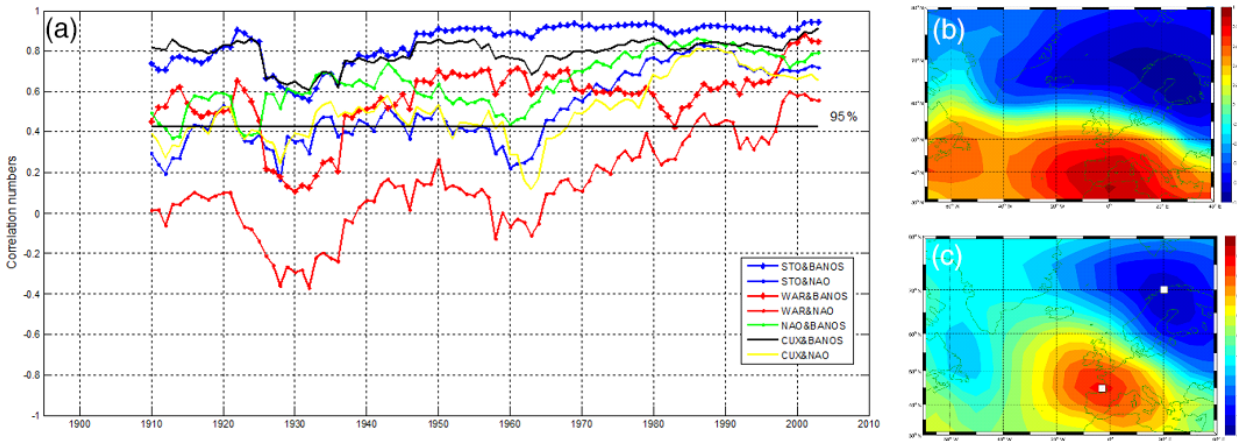
Figure 6. (a) Correlation between the NAO/the new index (BANOS) and winter mean sea level at Stockholm (STO), Warnemünde (WAR), and Cuxhaven (CUX) as well as the correlation between both indices. (b, c) Correlation maps for the periods when the correlation between the NAO and sea level variability were minimum (b) and maximum (c) . The two white points in panel (c) were used to construct the new BANOS index. Reproduced from Karabil et al. (2018) and distributed under a CC-BY